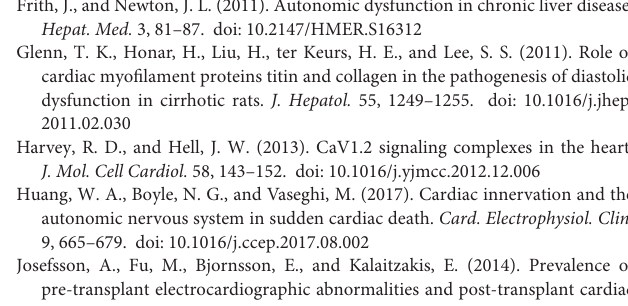
Supplementary Figure 1 | Bile duct ligation in the liver cirrhosis model. The ligation of bile duct was performed to induce liver cirrhosis in rabbits. The star represents the liver and the asterisk represents the duodenum that was connected to the common bile duct (CBD). The black arrows represent double ligations using 3-0 silk at the two ends of the CBD. The dotted line represents the dissection line between the two ligation